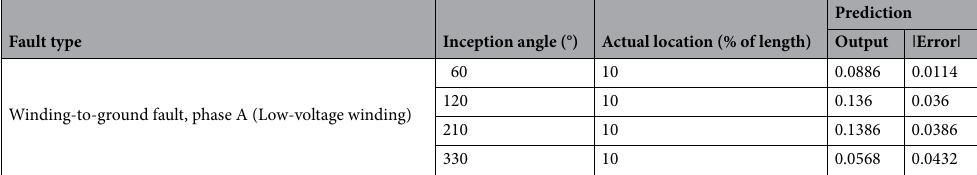
Table 6. Fault location for phase A winding-to-ground faults on low-voltage winding with various inception angles.